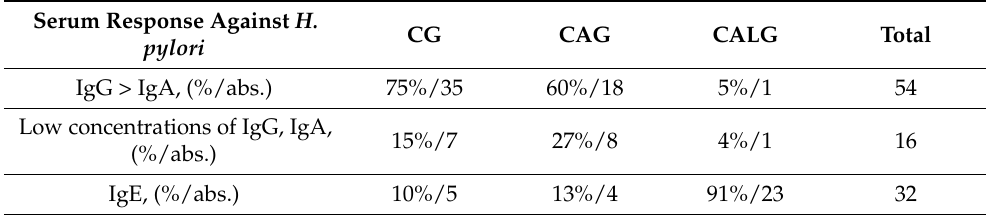
Table 3. Characteristics of serum responses (antibodies IgG, IgA, IgE) against H. pylori in various types of chronic gastritis